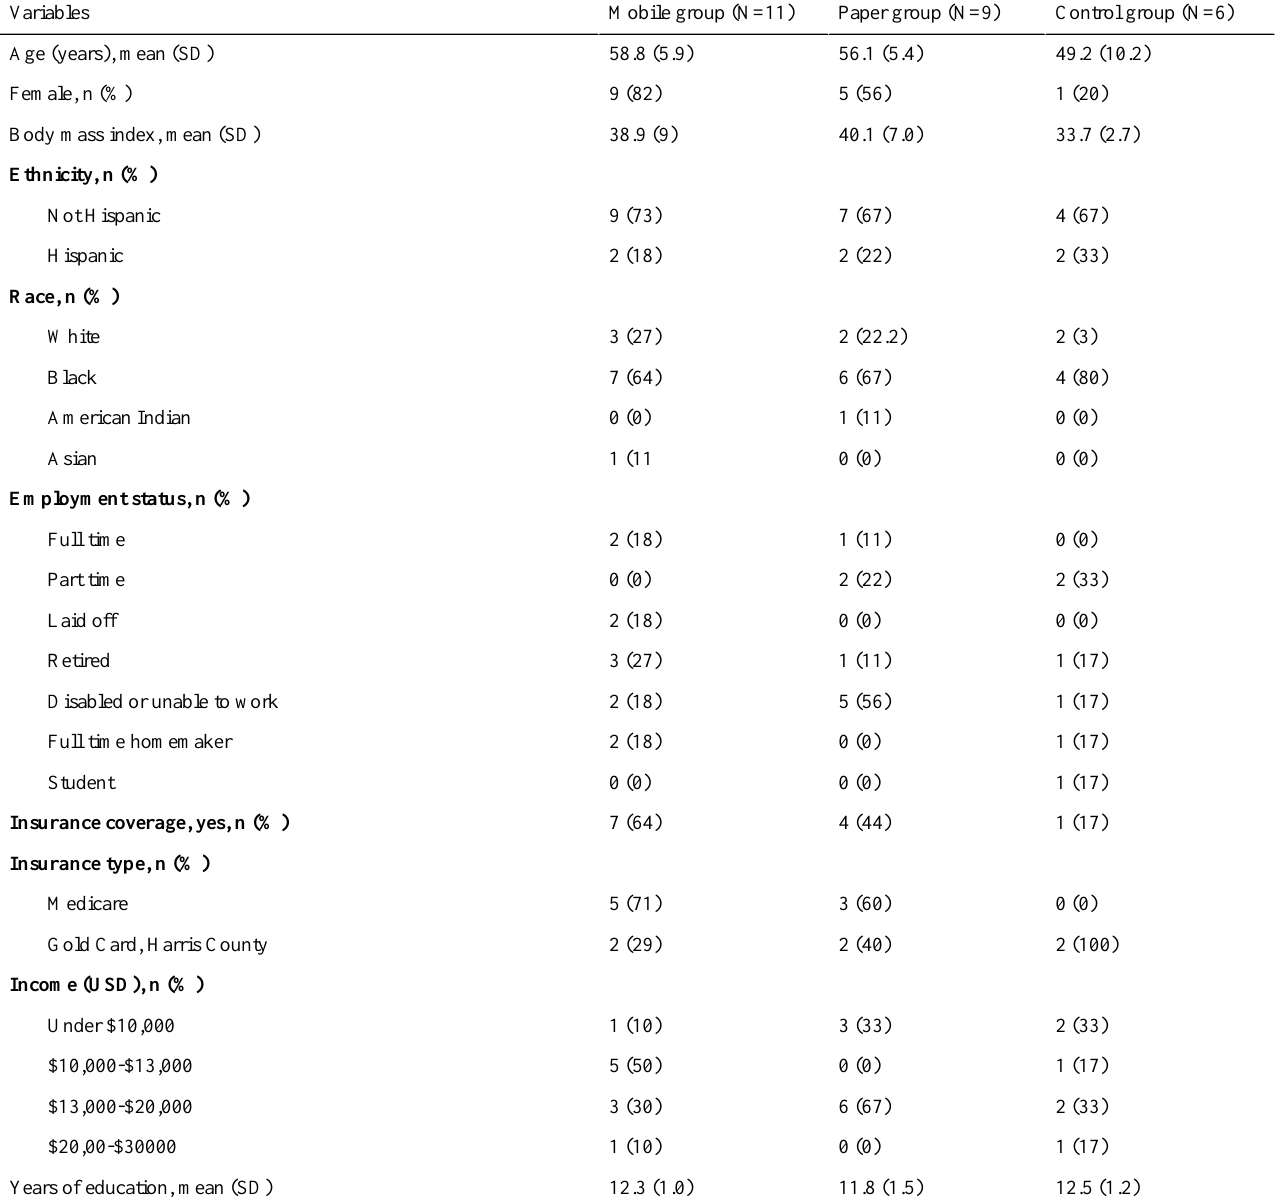
Table 2. Demographic characteristics by three